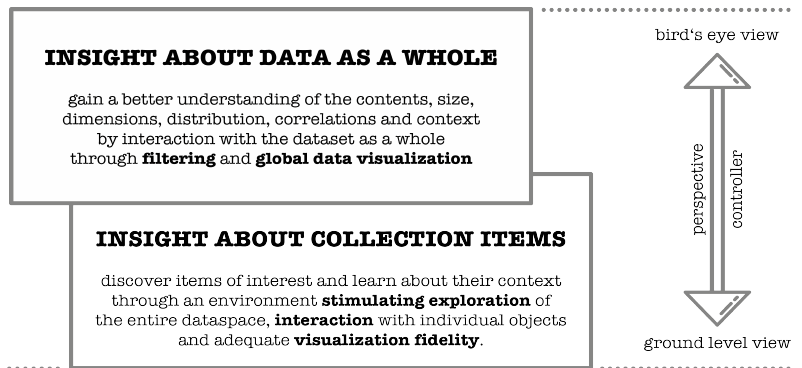
Figure 1. Two layers of the visualization concept: higher level for global data visualization and lower level to display information on individual collection